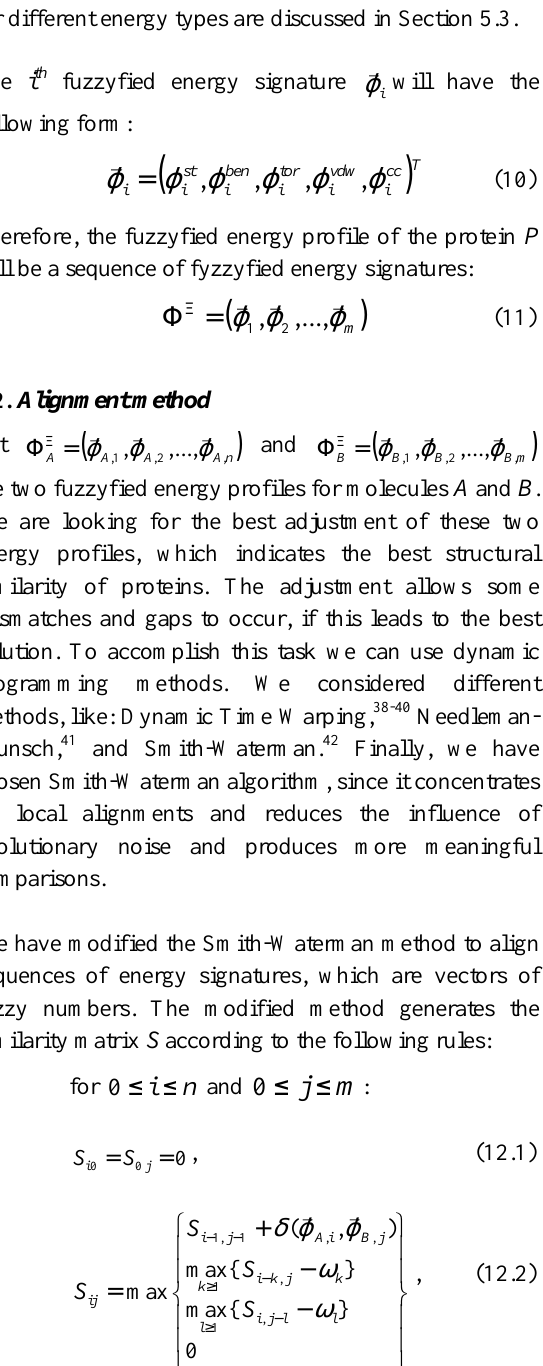
Fig. 6. Representation of a single component in the energy signature as a fuzzy